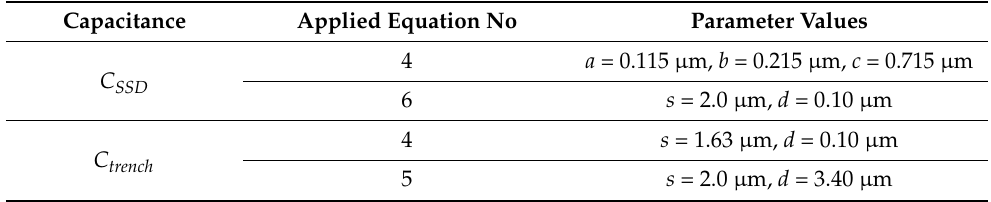
Table 2. Parameter values for each structural parameter of channel capacitances, C SSD and trench capacitance, C trench